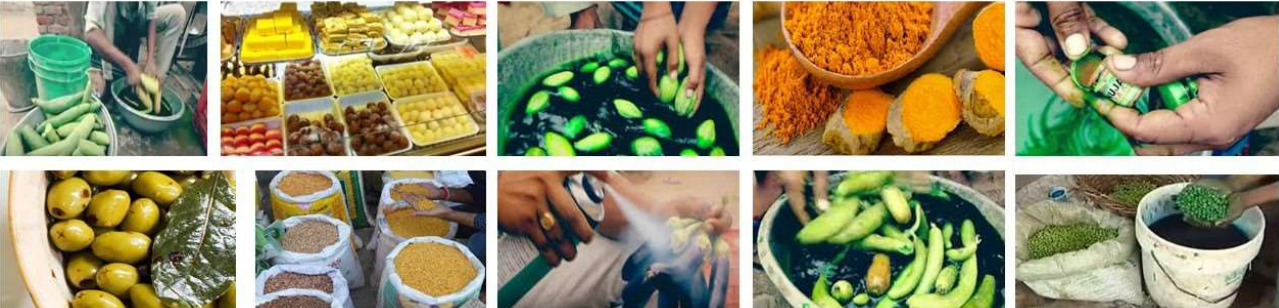
Figure 1. Various instances of vegetables and other consumables being adulterated with harmful chemicals. In most cases, cheap, industrial-grade dyes are used instead of food colors to maximize profits [11–14].